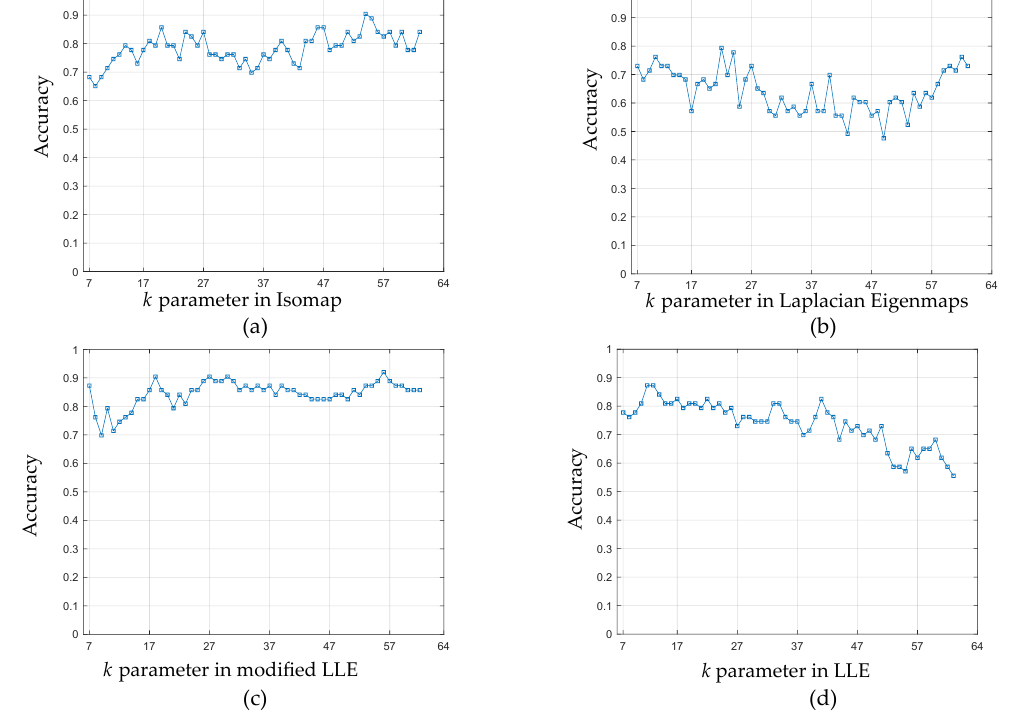
Figure 6. Accuracy sensitivity of k parameter variation in ( a ) Isomap; ( b ) Laplacian Eigenmaps; ( c ) Modified LLE; and, ( d )